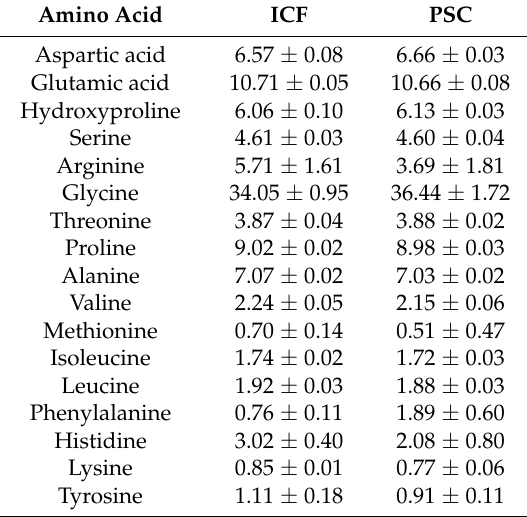
Table 1. Amino acid compositions of ICFs and PSCs from the body walls of Stichopus japonicas